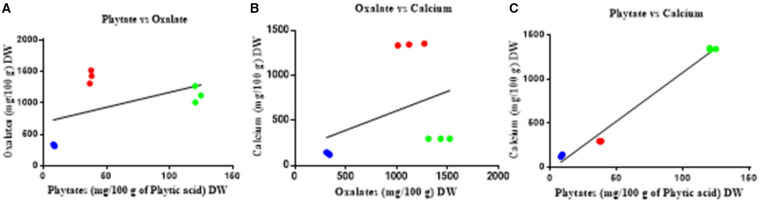
Correlation between oxalate, phytate, and calcium of T. ferdinandiana. (A) Phytate vs. oxalate, (B) oxalate vs. calcium, and (C) phytate vs. calcium in fruits , leaves , seedcoats . No significant associations were found except with phytate vs. calcium (pearson r = 0.9917; p < 0.001).